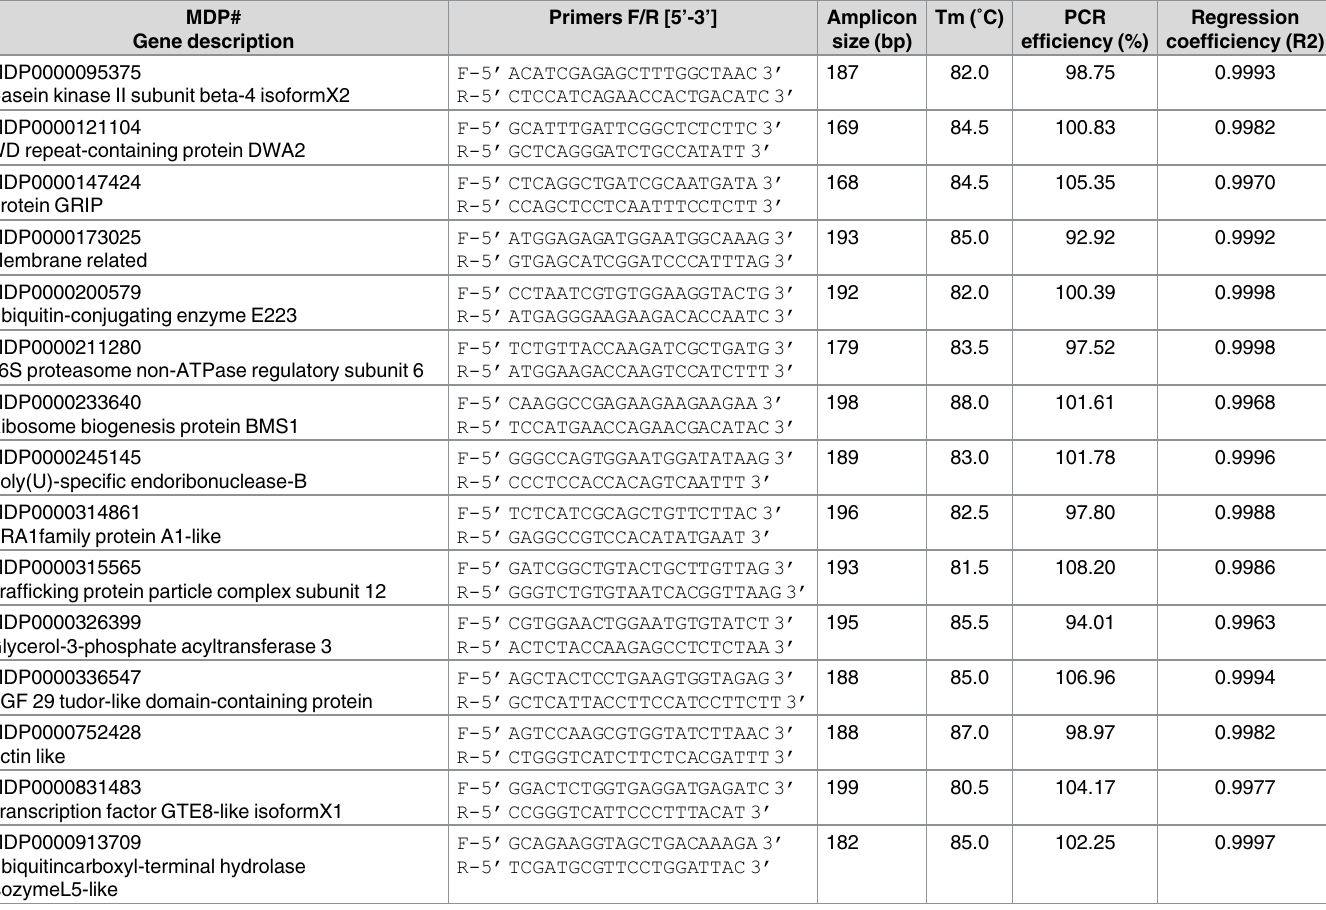
Table 2. Description of candidate referencegenes and primer sequences for